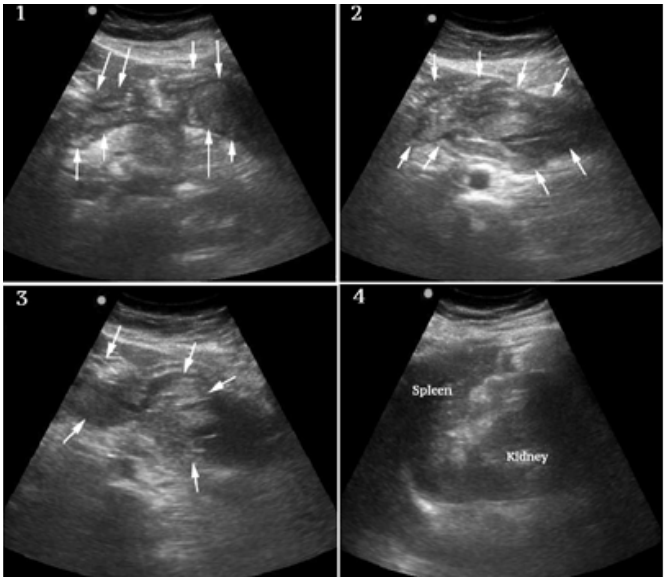
Figure 2. Frames 1-3 show alternate views of the extensive and organized clot formation in the epigastrium and left upper quadrant (arrows). Frame 4 shows the spleen which is grossly normal in size and